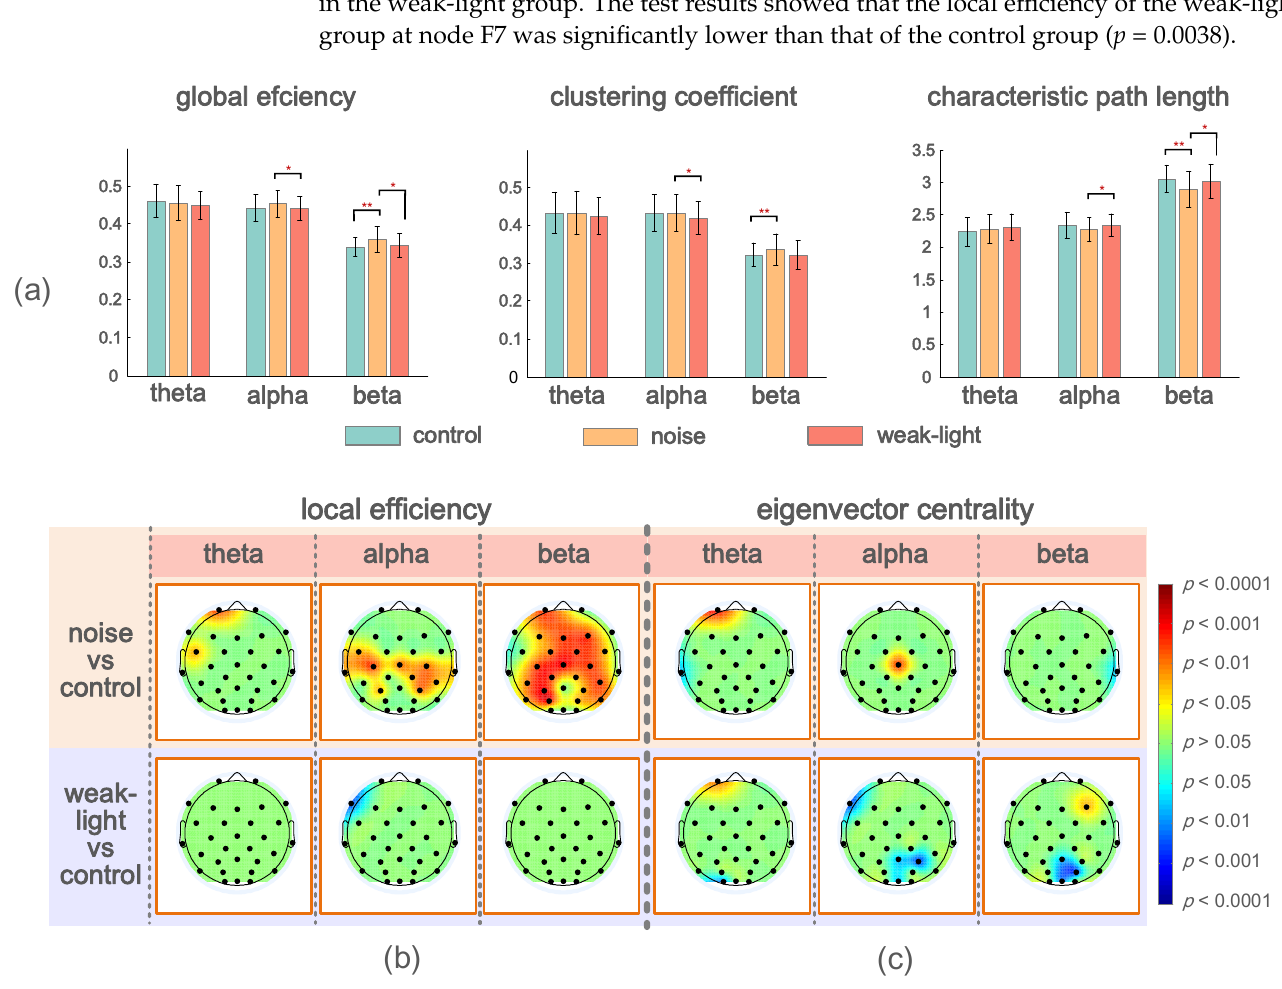
Figure 4. ( a ) Mean and standard deviation of global topological characteristics of brain network in theta, alpha, and beta bands of the control, noise, and weak-light groups. * p < 0.05 indicates a significant difference in the topological characteristics, and ** p < 0.01 indicates a very significant difference in the topological characteristics. ( b ) Topographic maps show significant local efficiency differences between the noise and weak-light groups and the control group. Red and blue are the electrode positions whose characteristic values were significantly higher/lower than those of the control group. ( c ) The topographic map shows significant differences between the eigenvector centrality in the noise, weak-light, and control groups.